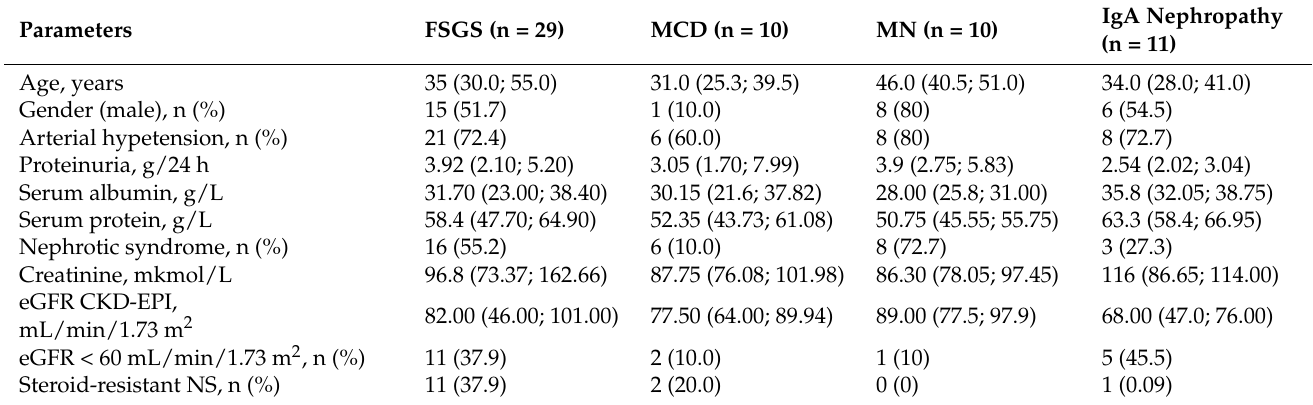
Table 4. Characteristics of the